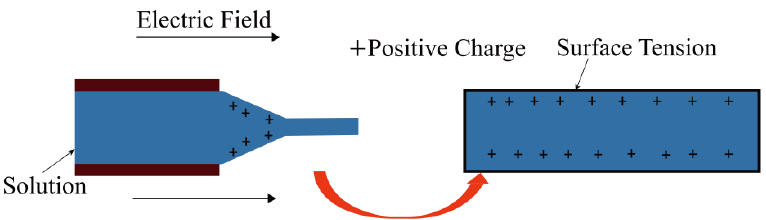
Figure 3. A schematic diagram of droplet stretching from the needle tip to the collection board in a high electric field.